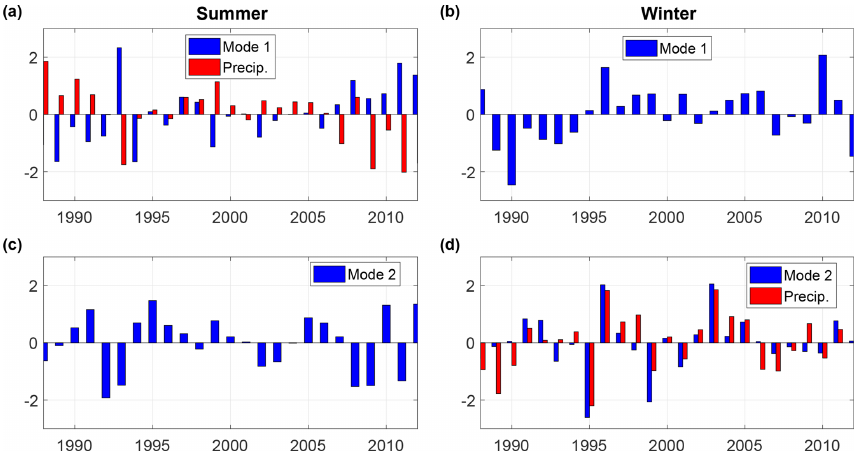
Figure 8. Variability of the first and second EOF modes (Fig. 7). In (a, d) , the variability of the net seasonal precipitation, integrated over the ice sheet, obtained from MAR, is also shown. For ease of comparison, all parameters were normalized by their mean and standard deviation over the investigated period.